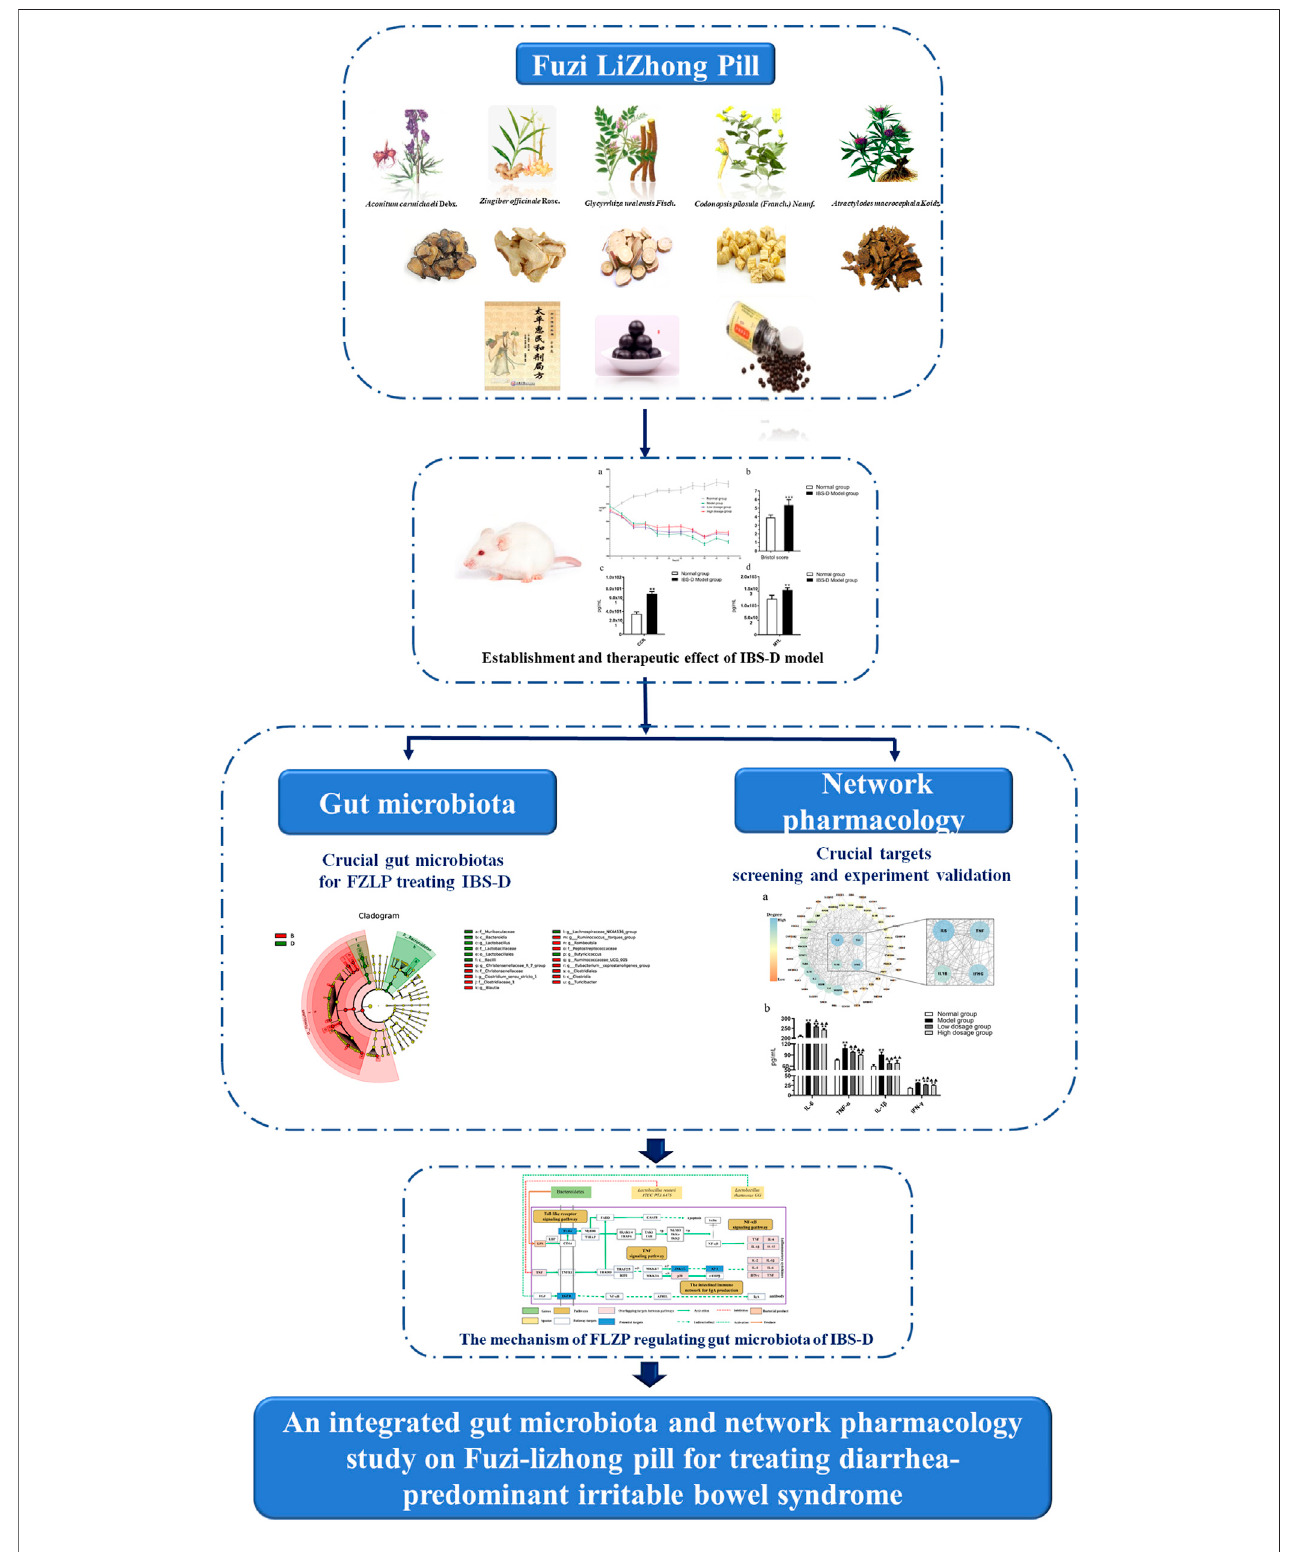
FIGURE 7 | The graphical abstract of the research.